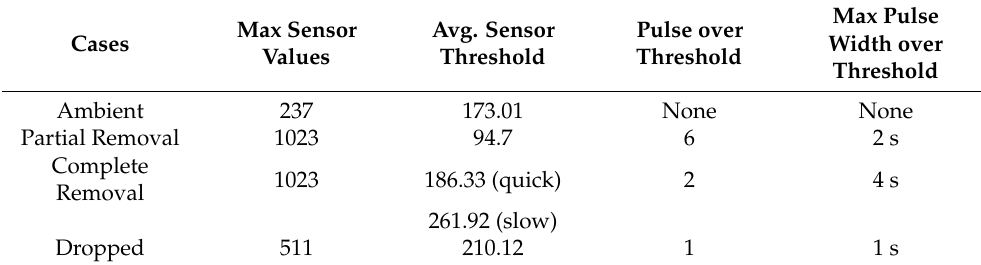
Table 1. Summary of the